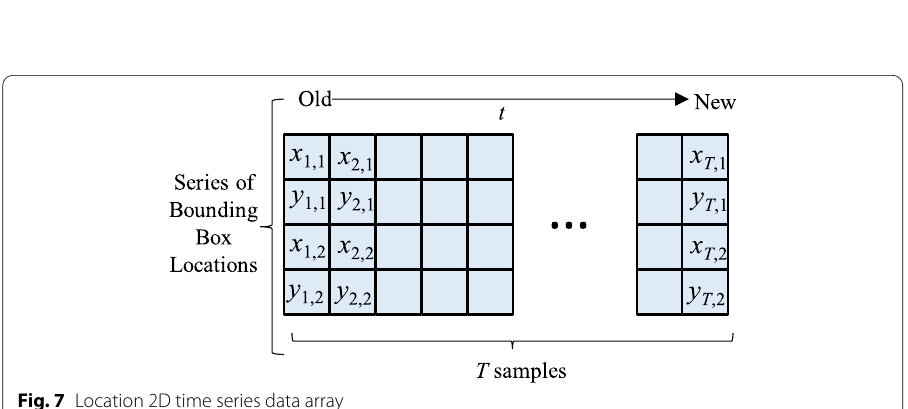
Fig. 6 Priority orders of detected objects: a ordered in the confidences; b ordered in the regulated distance to the reference point with ρ 0.5 =